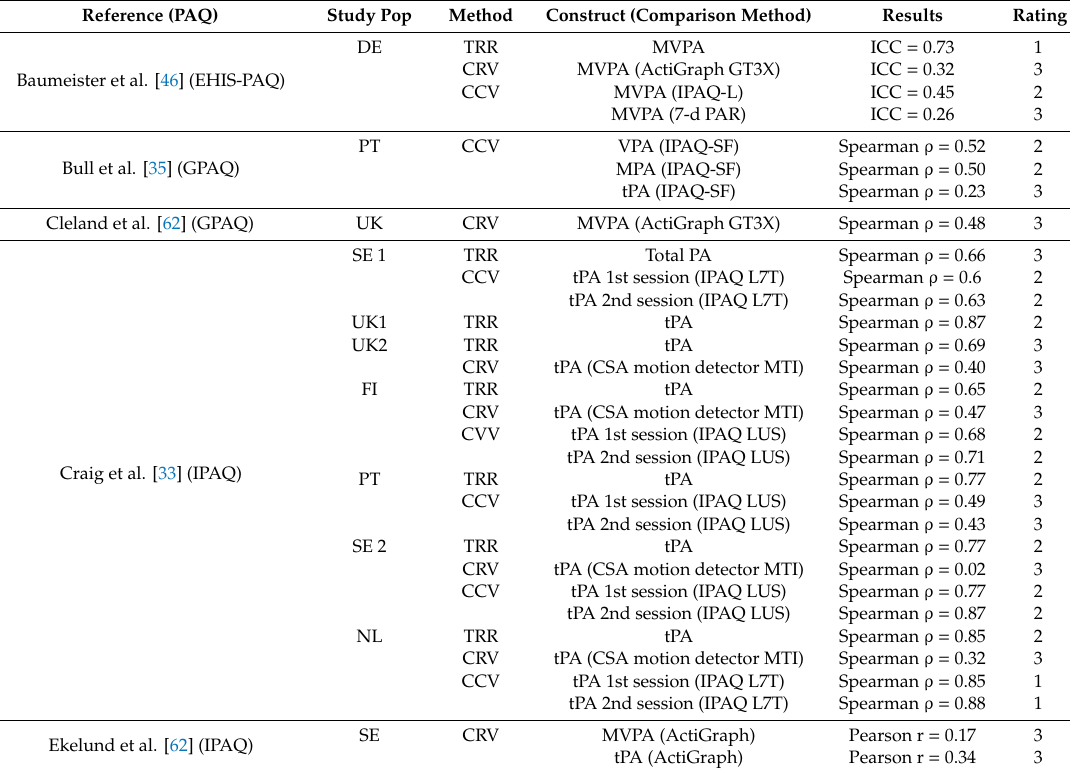
Table 2. Results for test-retest reliability, concurrent validity and criterion